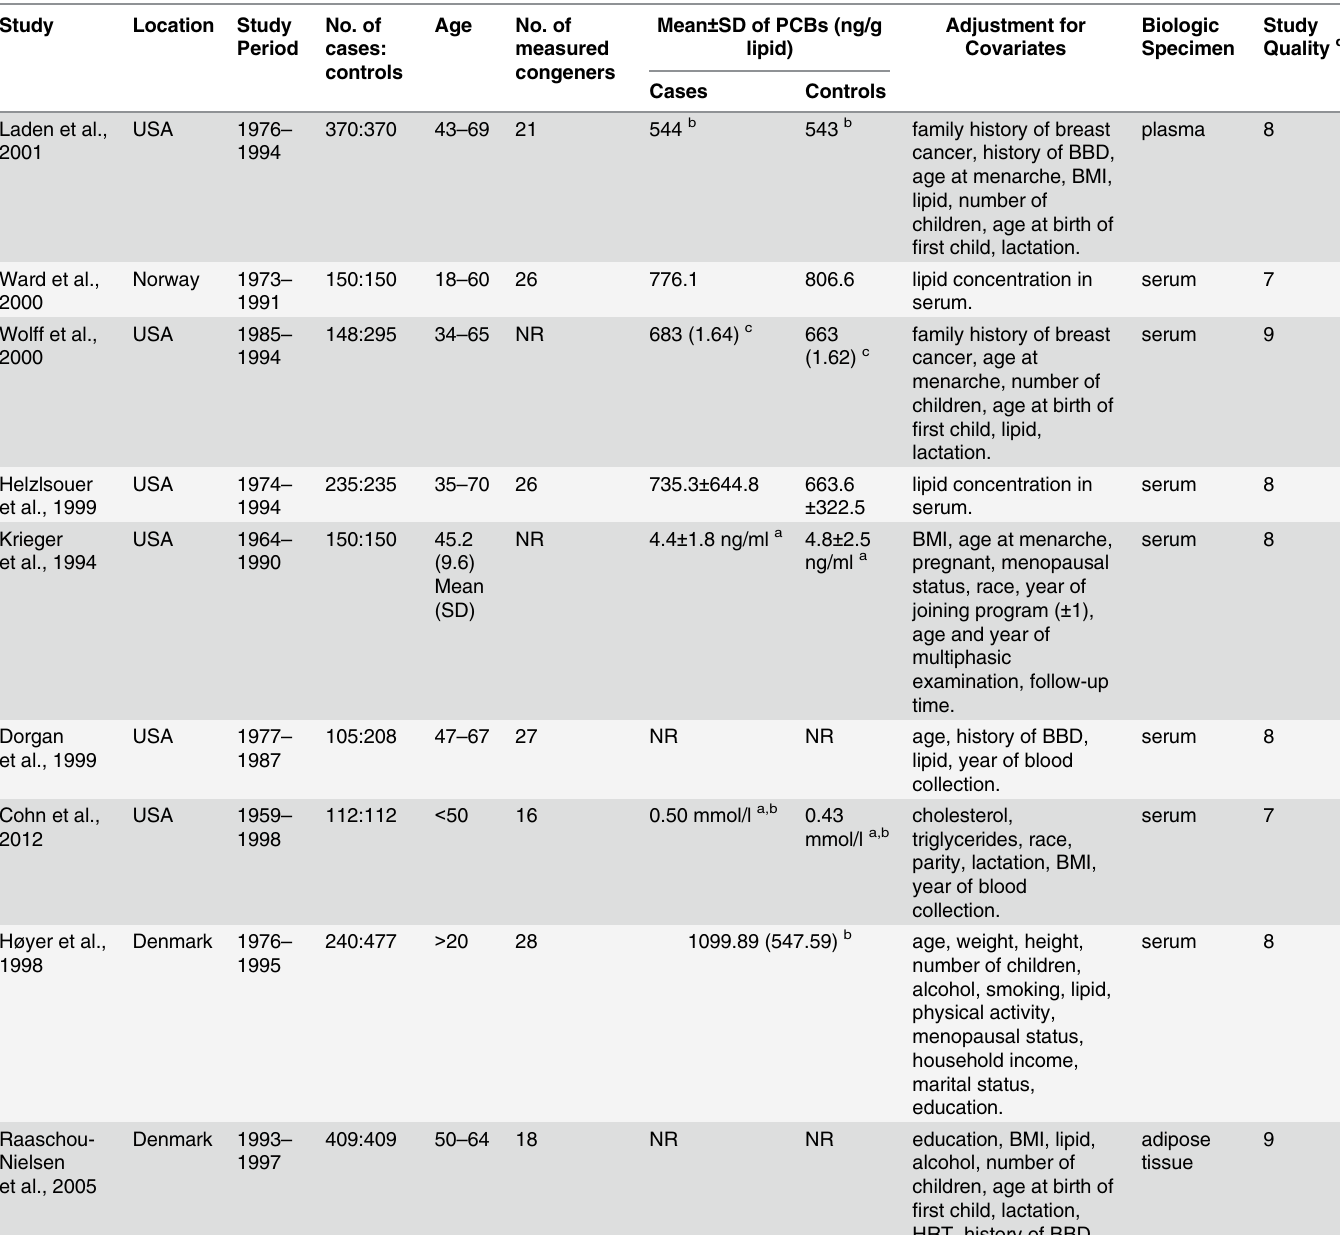
Table 1. Characteristics of prospective epidemiologic (nested case-control) studies on PCB exposure and breast cancer risk.